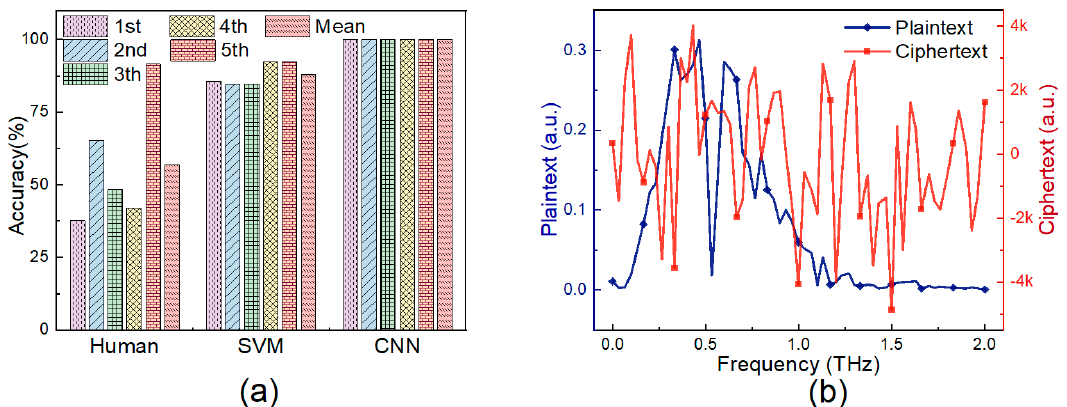
Figure 6. ( a ) Comparison of accuracy on each fold for human, support vector machine (SVM) and CNN; ( b ) Plaintext and ciphertext of one THz signal.